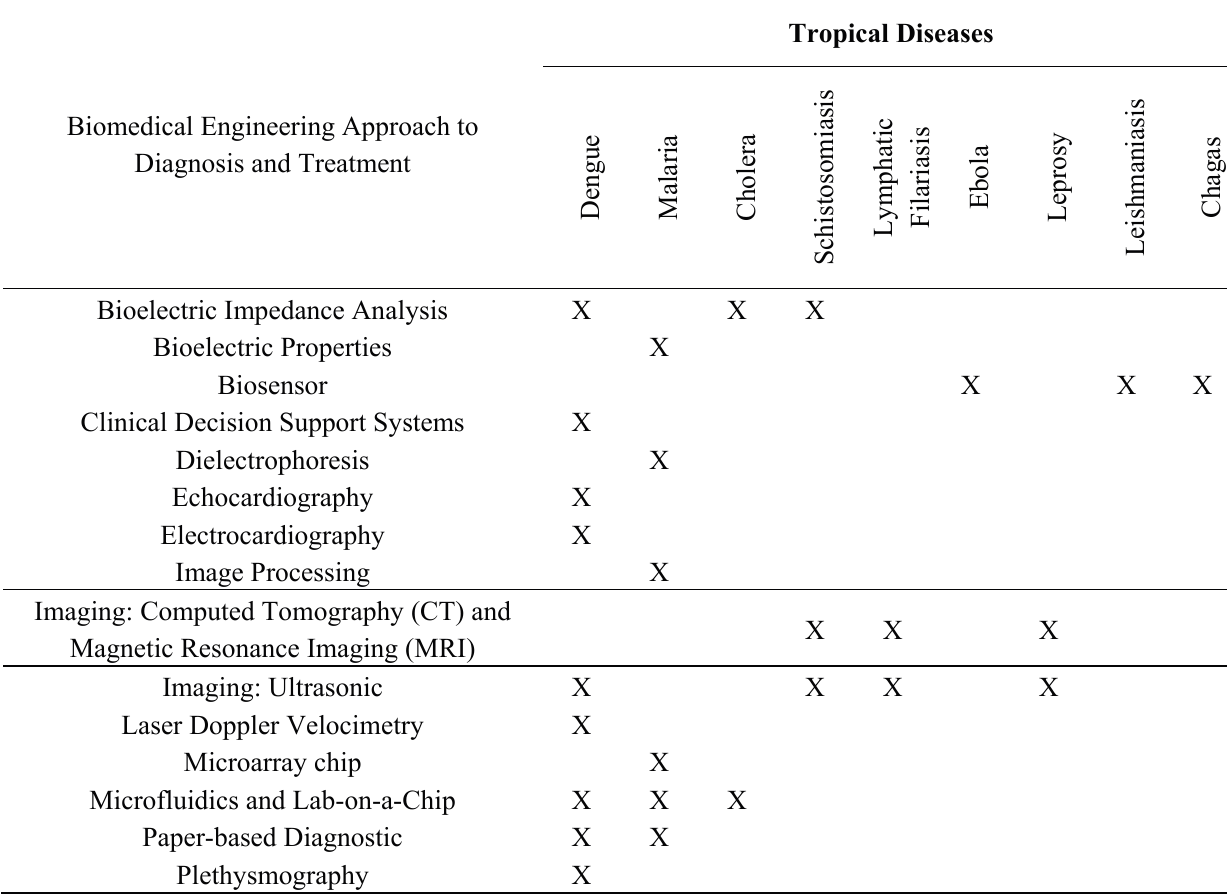
Table 1. Relation between the Tropical Diseases and their Diagnosis and Treatment via Biomedical Engineering